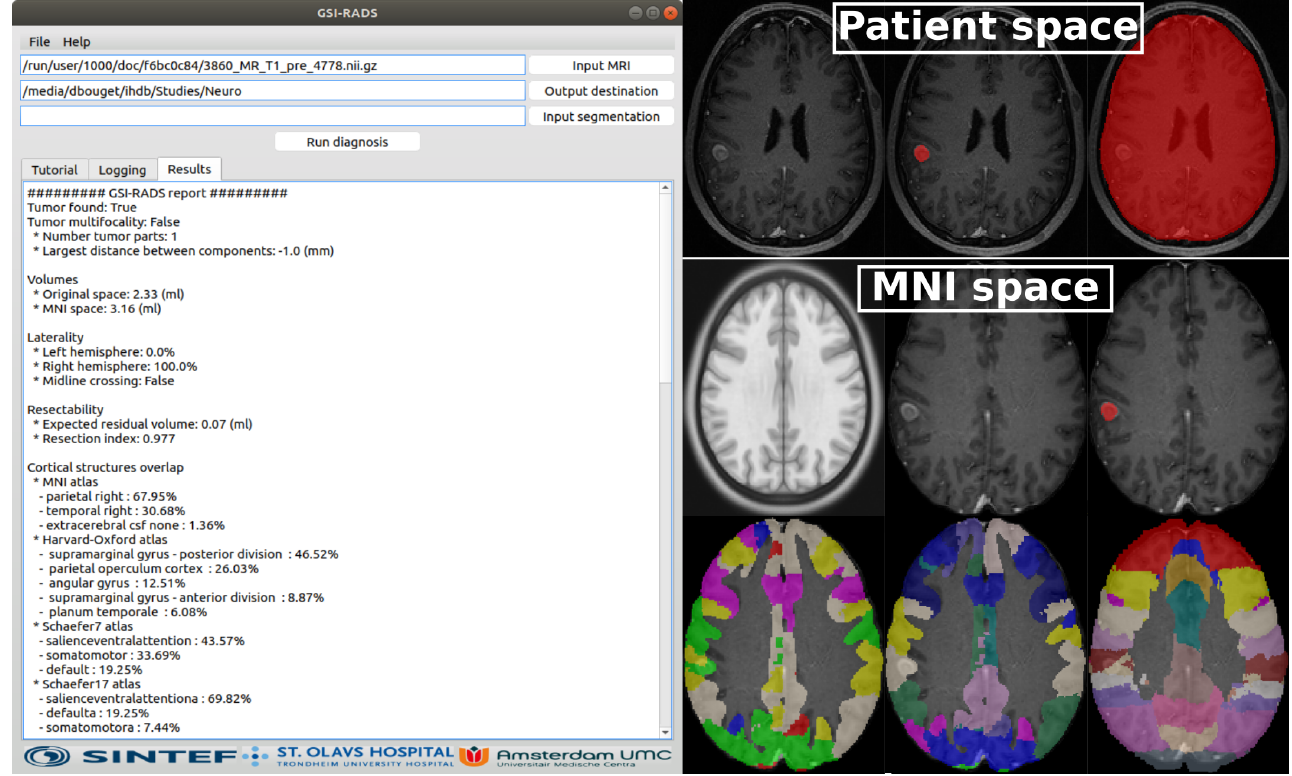
Figure 3. Illustration of the proposed GSI-RADS. The GUI (Graphical User Interface) is presented to the left with a standardized report. To the right, the different outputs both in the patient and MNI space are illustrated. In the bottom row, the Schaefer7, Schaefer17, and Harvard-Oxford cortical structures are respectively